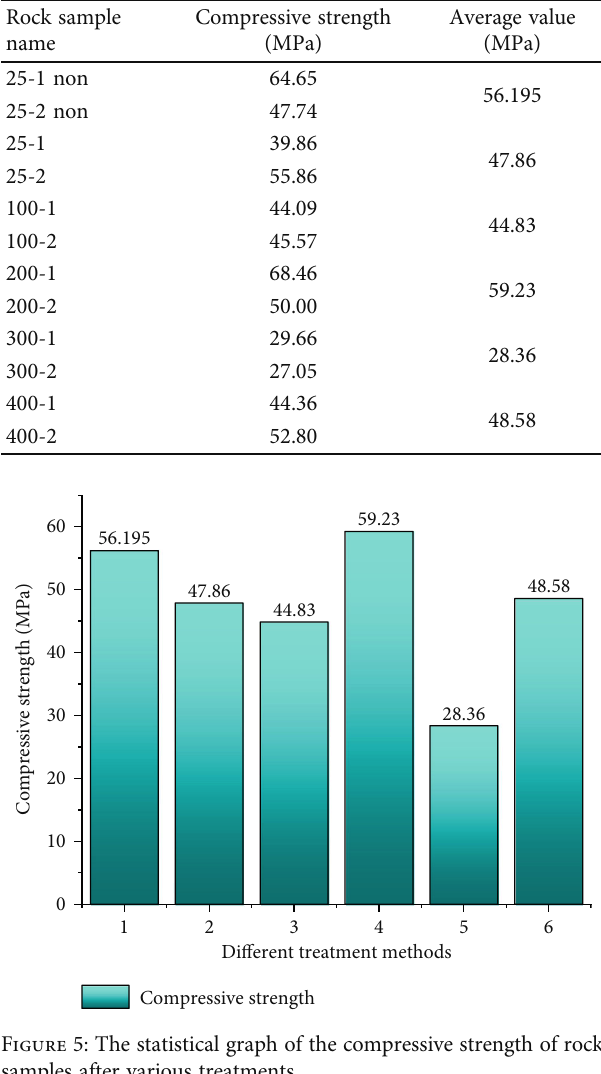
Table 1: Compressive strength data of di ff erent specimens.